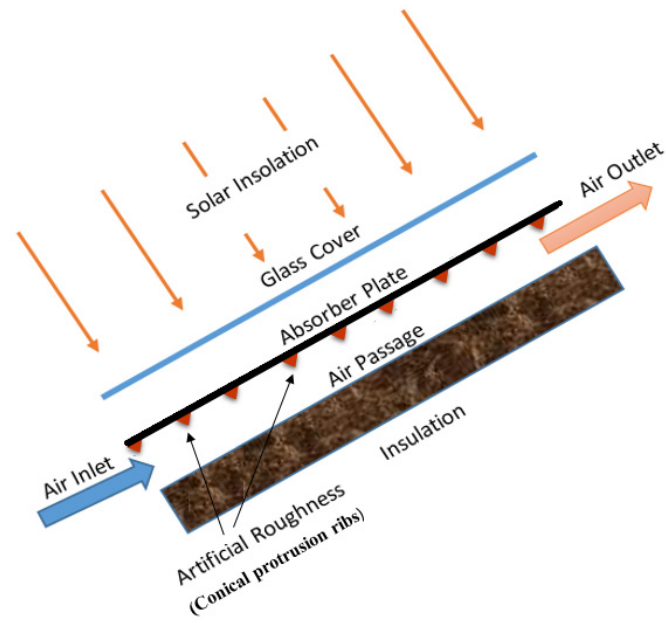
Figure 1. Schematic diagram of an SAH.